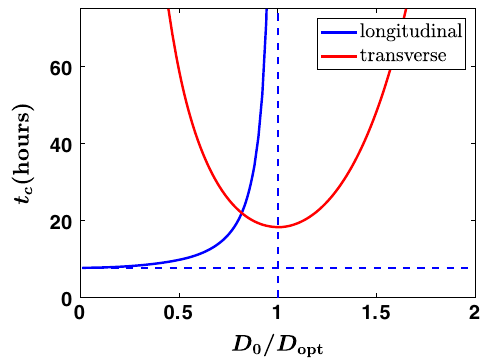
FIG. 3. Transverse and longitudinal cooling times as a function of